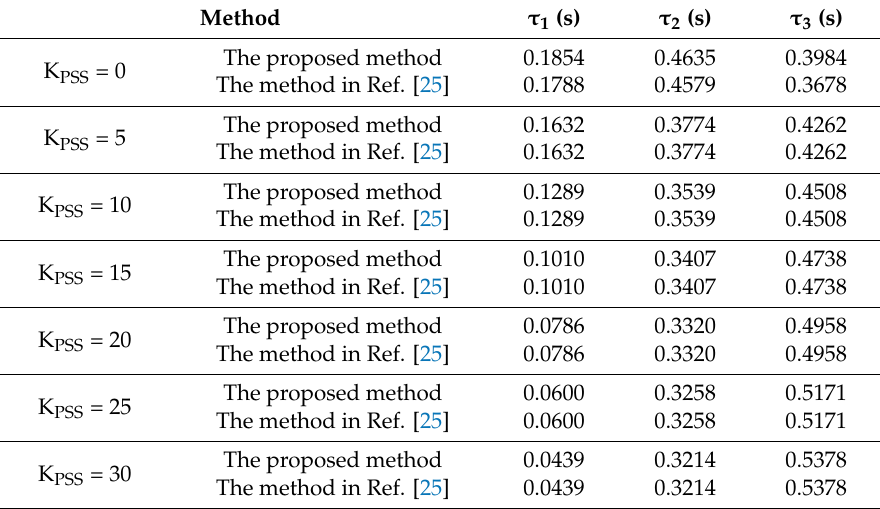
Table 3. The delay margin with different values of the PSS gain, K PSS .